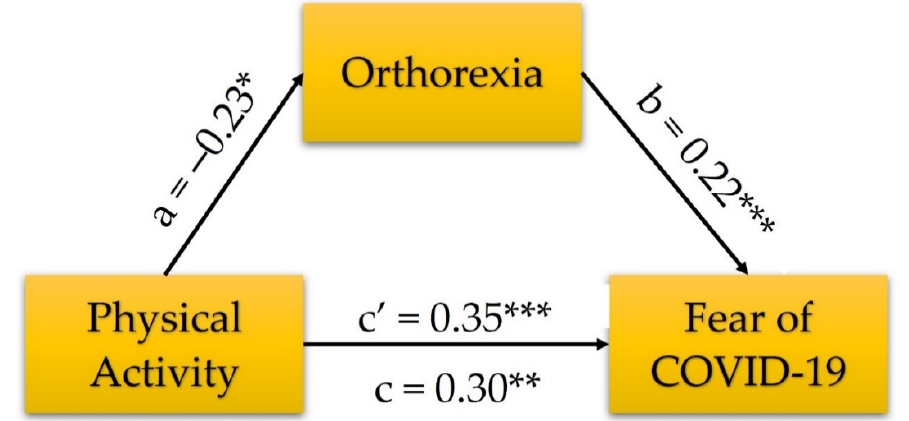
Figure 3. Orthorexia as a mediator of the relationship between physical activity and fear of COVID with standardized coefficients. * p < 0.05, ** p < 0.01, *** p < 0.001.